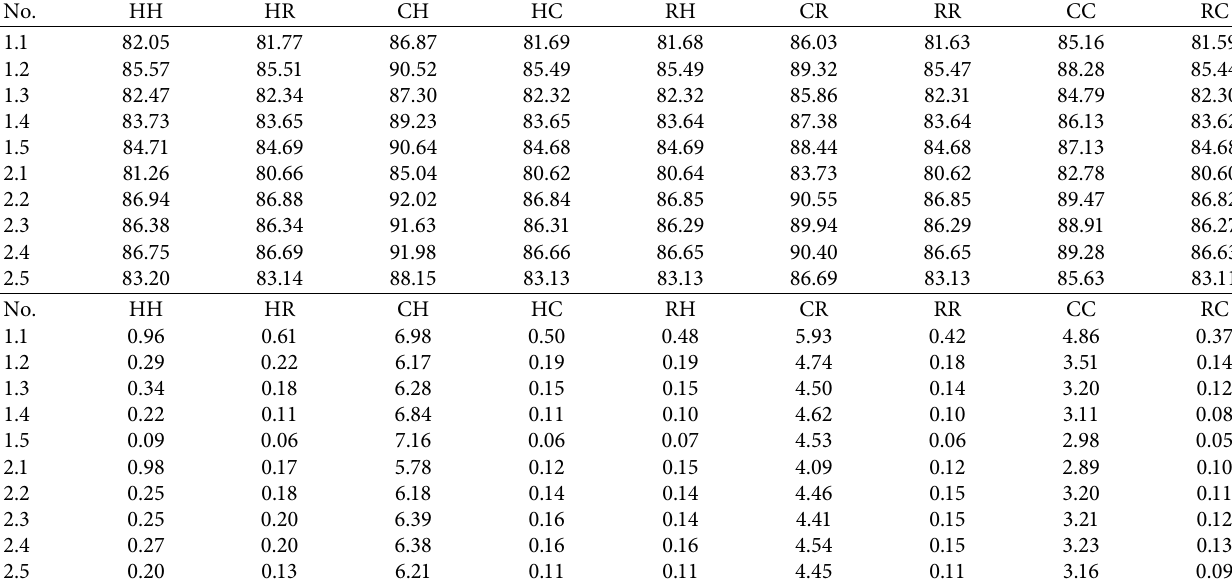
Table 17: Mean percentage qualities of the best-found schedules returned by the LS algorithms (the top table) and mean percentage improvements of the lengths of schedules returned by the LS phase with respect to the lengths of schedules returned by the initialization phase (the bottom table) for each of the ten classes of the benchmark given in [9] with cov � 80%.